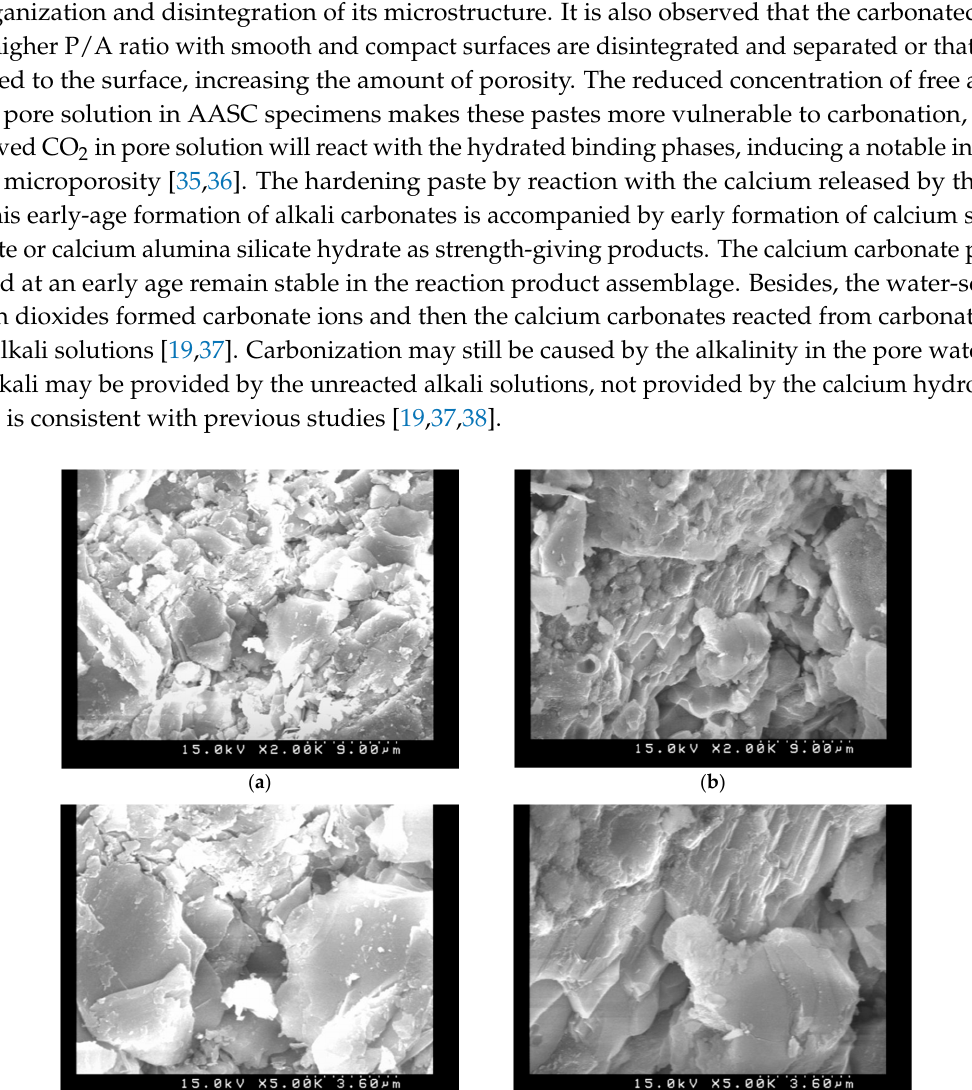
Figure 7. Carbonation rate (pH indicator): ( a ) P/A = 0.635, L/B = 0.5; ( b ) P/A = 0.635, S/A = 0.2 & 0.6;